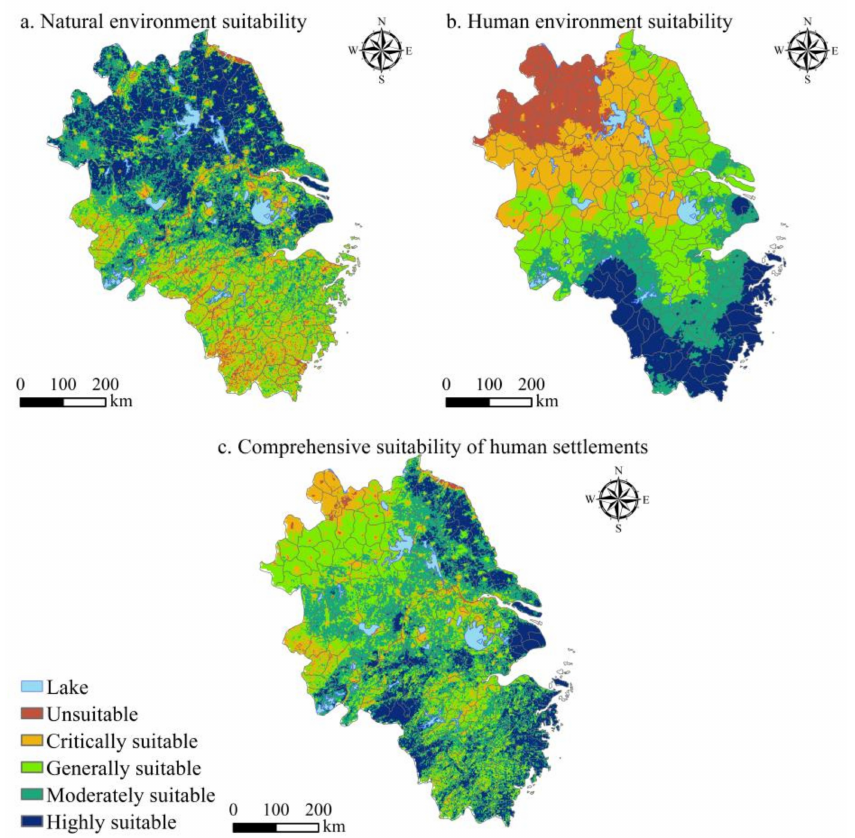
Figure 6. Spatial distribution of natural, human, and comprehensive index levels of human settle- ments suitability in the